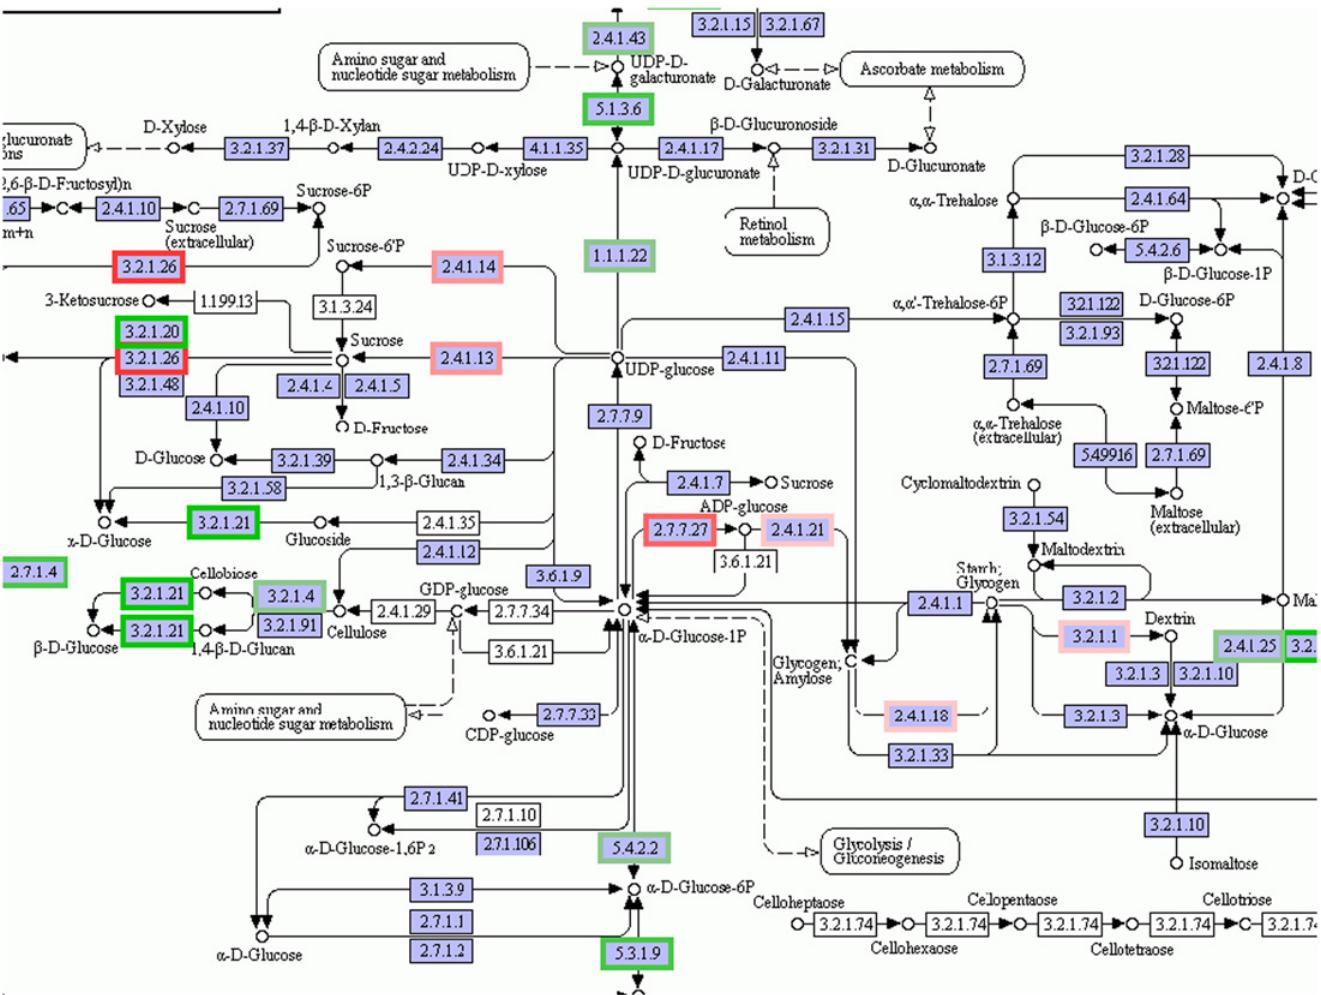
Fig 6. KEGG pathway visualization of starch and sucrose metabolism changes under salt stress. The enzymes circled by red frame are up-regulated in salt stress; the enzymes circled by green frame are down-regulated in salt stress in addition the more obvious variation with deeper